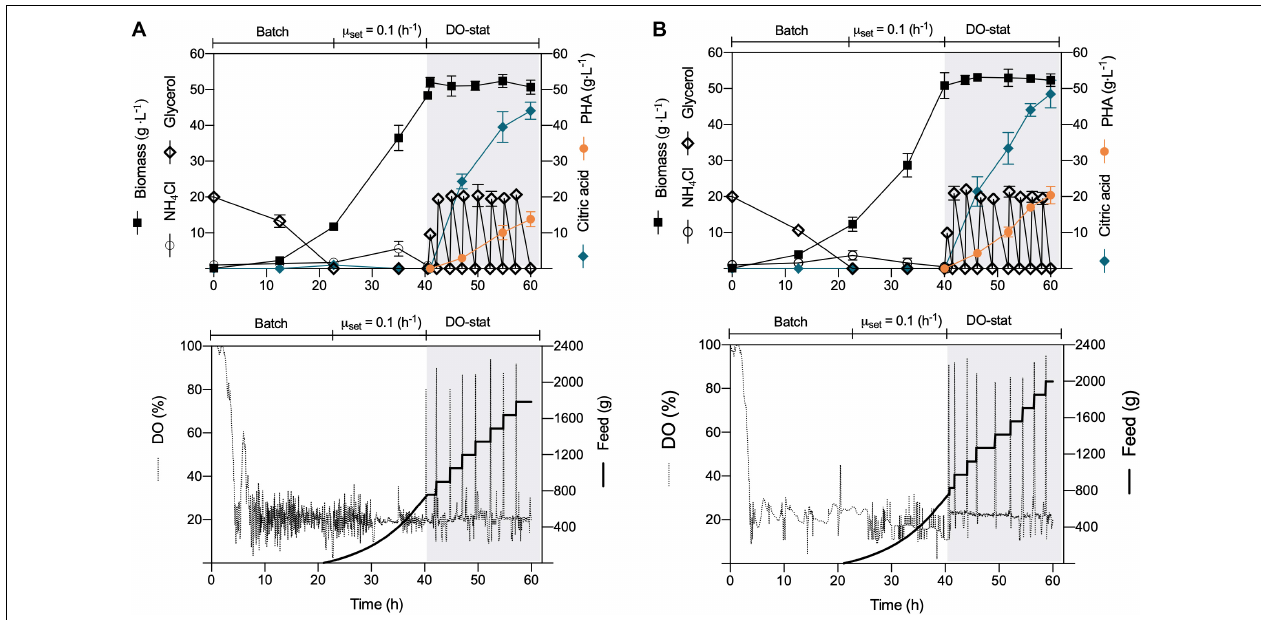
FIGURE 2 | DO-stat fed-batch mcl -PHA production. The culture comprised three phases: (i) batch, (ii) exponential feeding, and (iii) DO-stat response for substrate feeding under nitrogen limitation. Time profile of (A) P. putida KT2440 and (B) phaZ -knockout mutant. The data represent the mean values and standard deviation from two independent